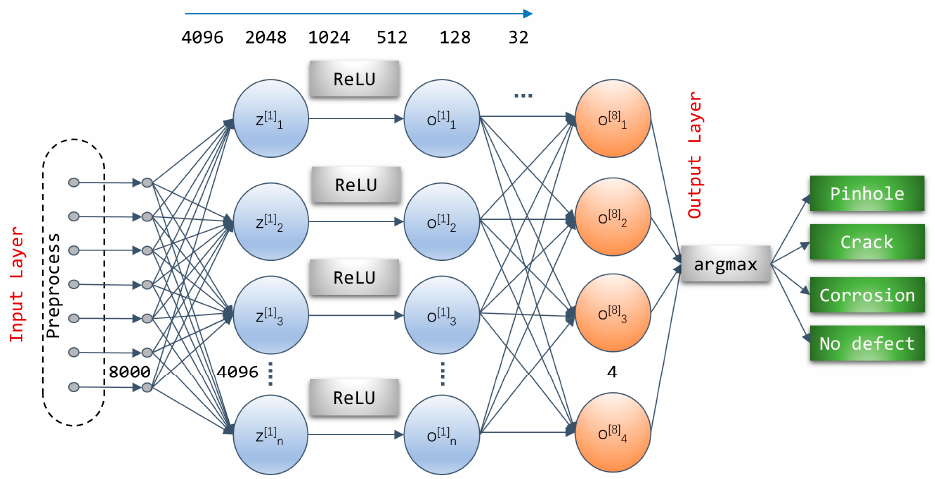
Figure 6. Deep fully connected neural network structure.